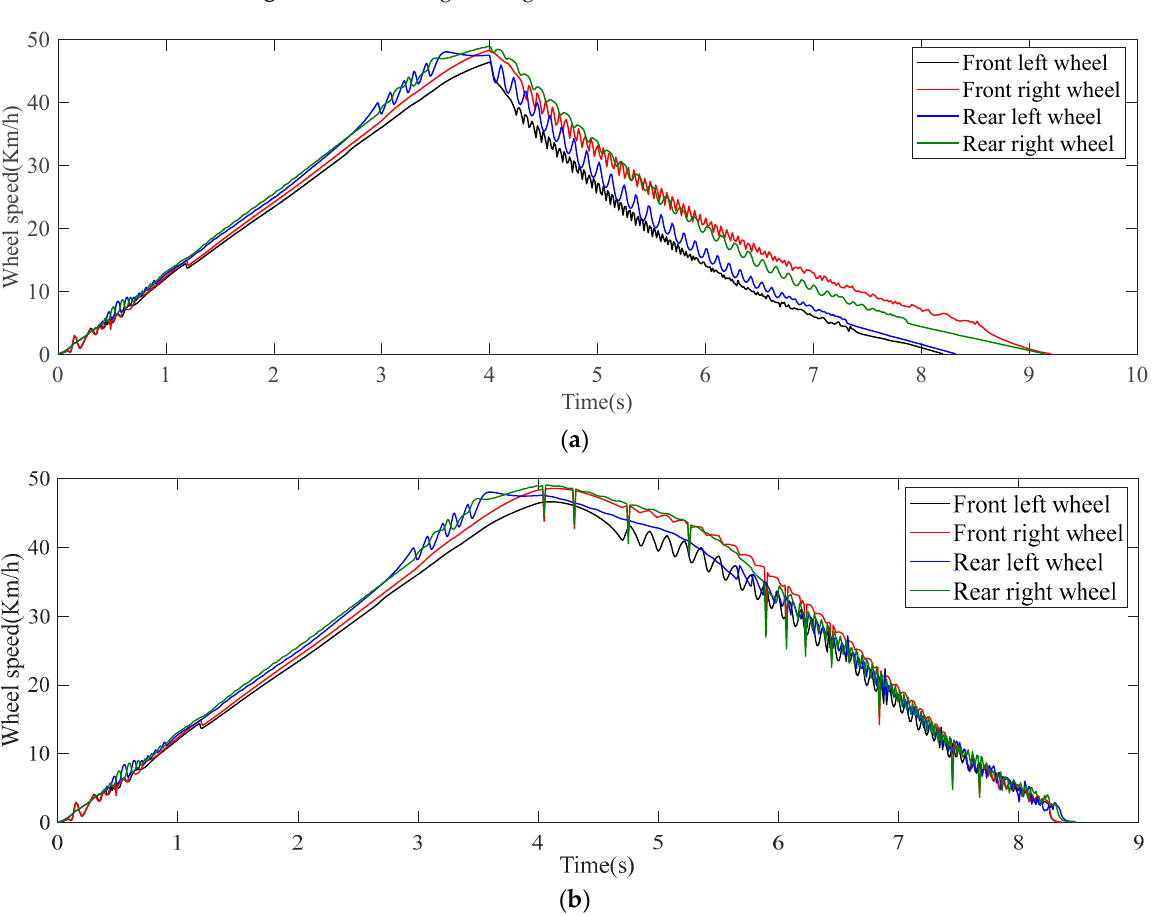
Figure 14. The variation curve of wheel speed. ( a ) Vehicles equipped with WAAS, VACAS and HRBS; ( b ) vehicles equipped with WAAS and HRBS.